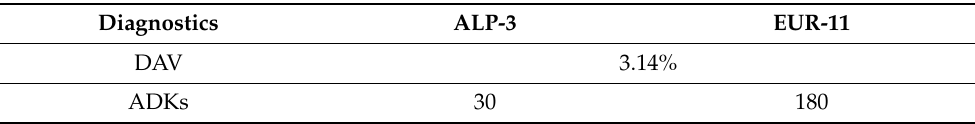
Figure 3. Empirical cumulative distribution functions ( a ) and probability density functions ( b ) related to heavy precipitation 99p from daily data. The observations are filled with a grey area. Table 4. Distribution added value (DAV) and Anderson–Darling rank statistics (ADKs) referred to the daily cumulative distribution function (CDF) and probability density function (PDF) of heavy precipitation in Figure